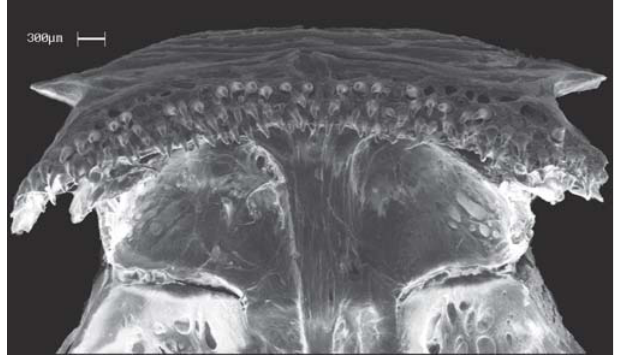
Fig. 3. SEM photograph of premaxilla, ventral view, anterior toward top of page, in Propimelodus araguayae , INPA 26121, paratype.